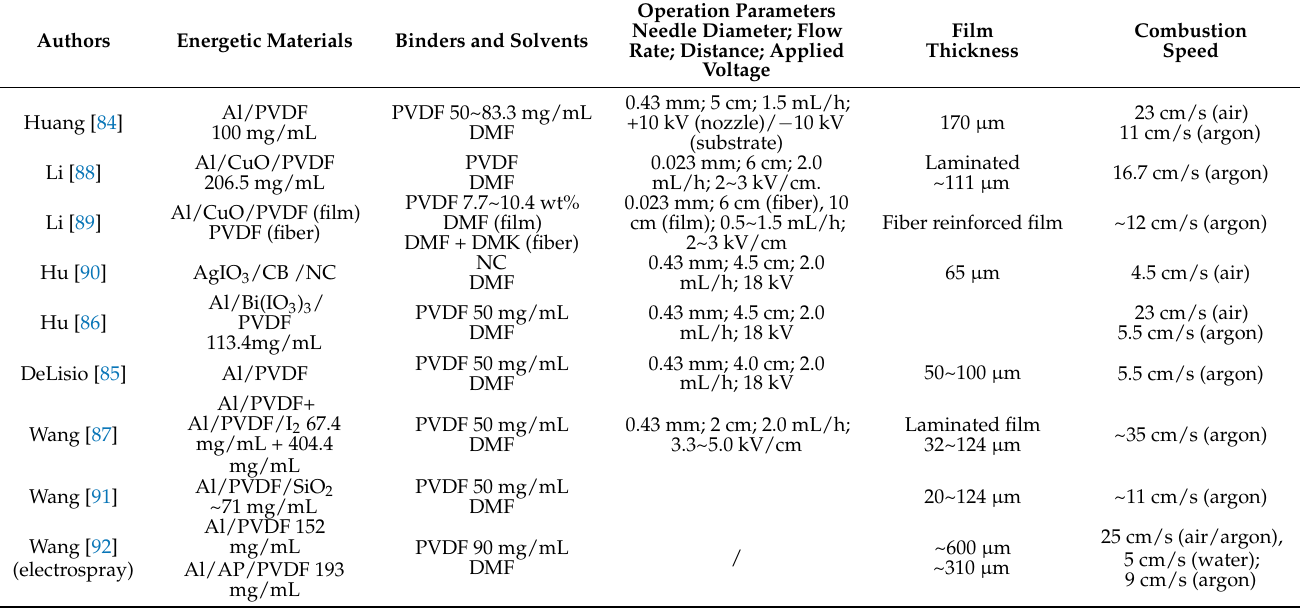
Table 4. Summary of energetic films deposited by